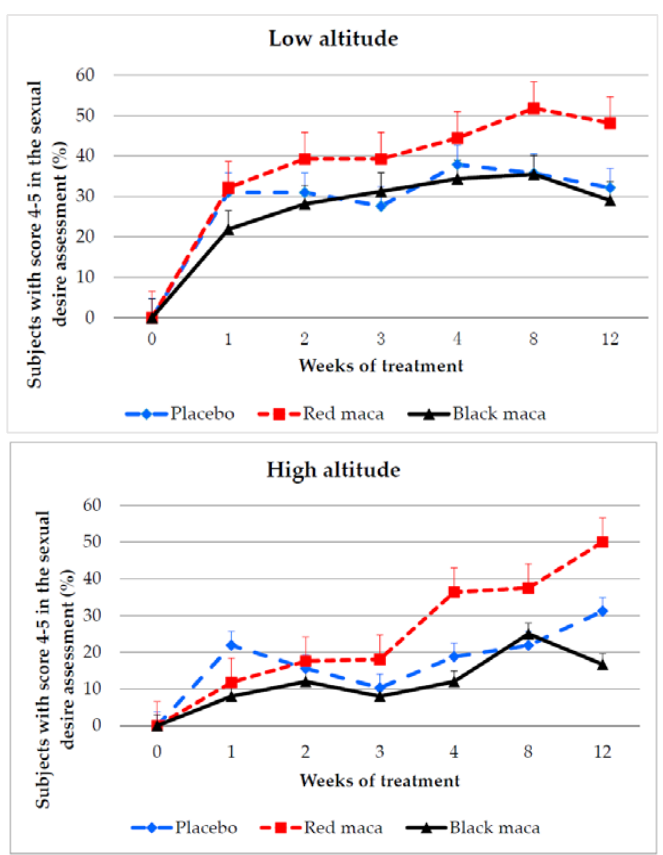
Figure 1. Percentage of subjects perceiving an increase in sexual desire following a 12 ‐ week treatment with the placebo or a spray ‐ dried extract of red or black maca at low ( A ) and high altitudes ( B ). Bars are standard error. At LA, consumption of spray ‐ dried extract of red maca increases the percentage of subjects with increased sexual desire over time ( p = 0.0055). p > 0.05 between placebo and maca ‐ treated groups. HA: p = 0.0027, p = 0.0000, and p = 0.0019 over time for treatments with placebo, red maca, and black maca, respectively. p = 0.03 (chi square = 6.96) at week 12 between treatment with spray ‐ dried extract of red maca and placebo or spray ‐ dried extract of black maca.